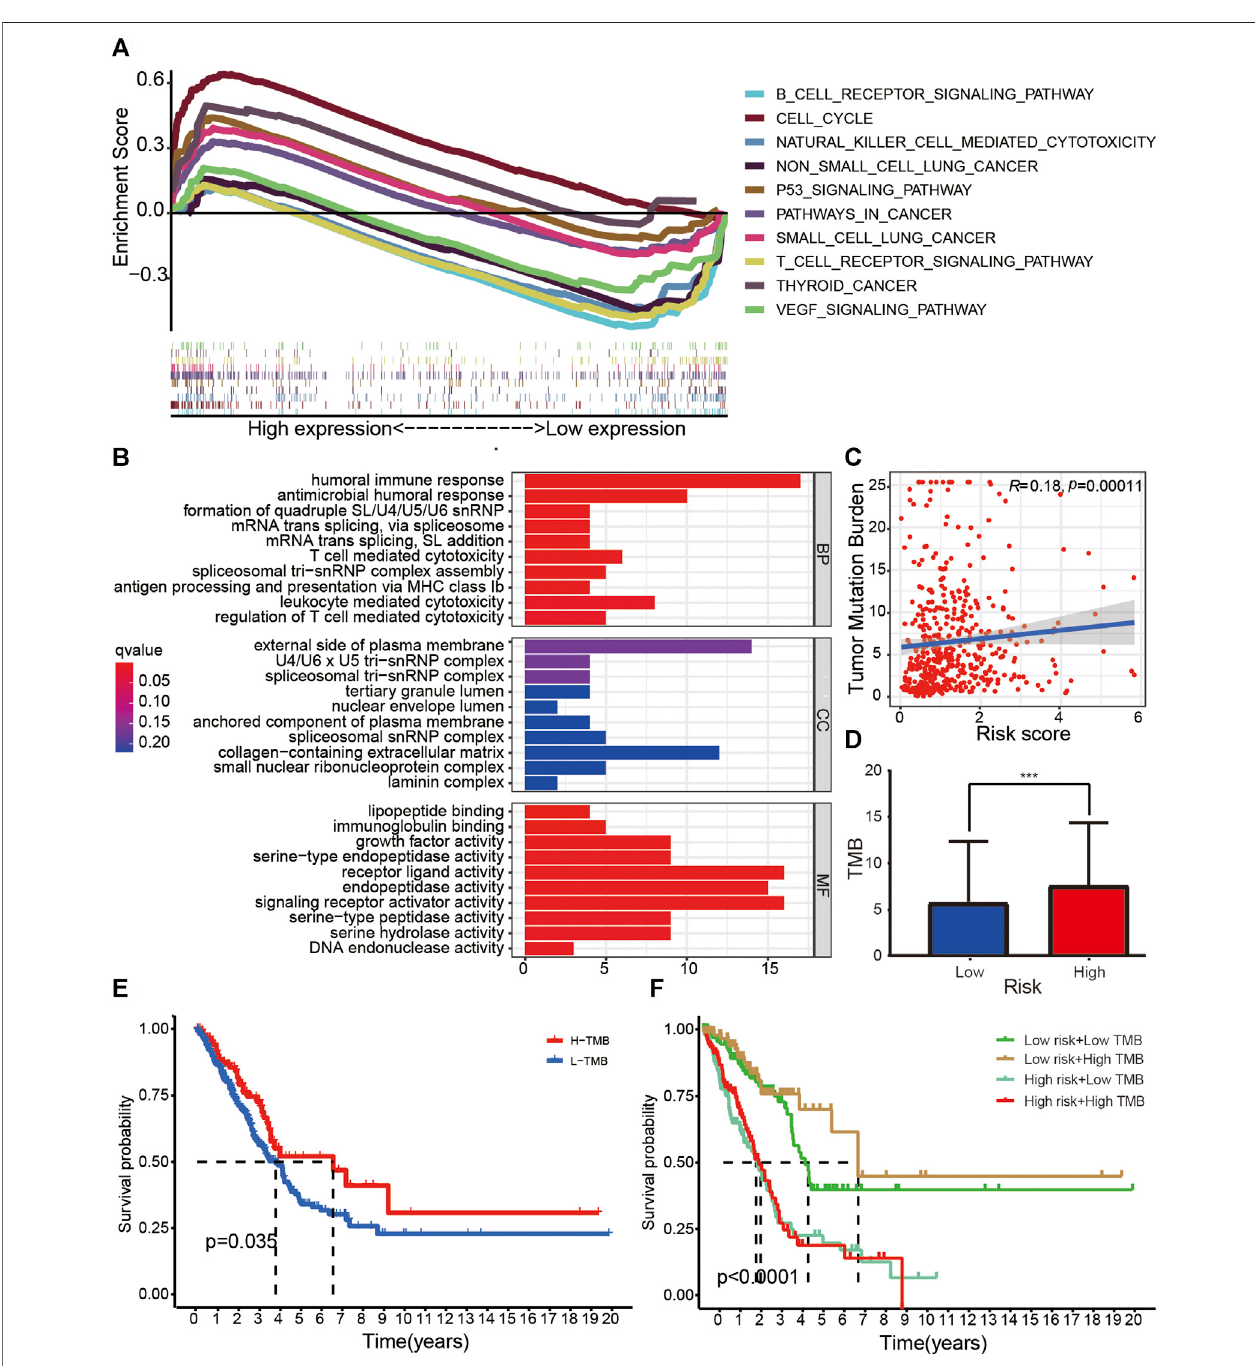
FIGURE 6 | Research on tumor immunity of the 14-ARlncRNA signature. (A,B) KEGG (A) and GO (B) function enrichment analyses reveal that several immune pathways and immune function were enriched in different groups, suggesting the ARlncRNA signature may be associated with tumor immunity. (C,D) The scatter diagram (C) and column diagram (D) show that high-risk patients exhibit signi fi cantly higher TMB. (E,F) The survival curves indicate that patients with a combination of low-risk and high TMB showed a greater prognosis.